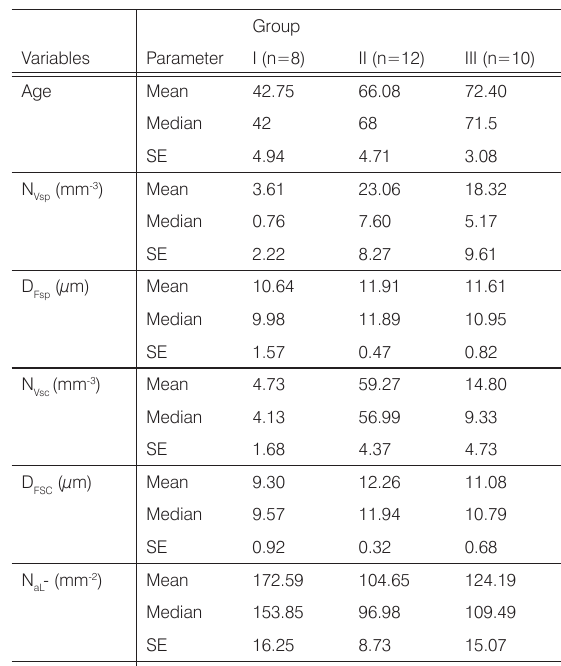
Table 3. Morphometric characteristics of CA and lipofuscin-bearing neurons in groups obtained as the result of cluster